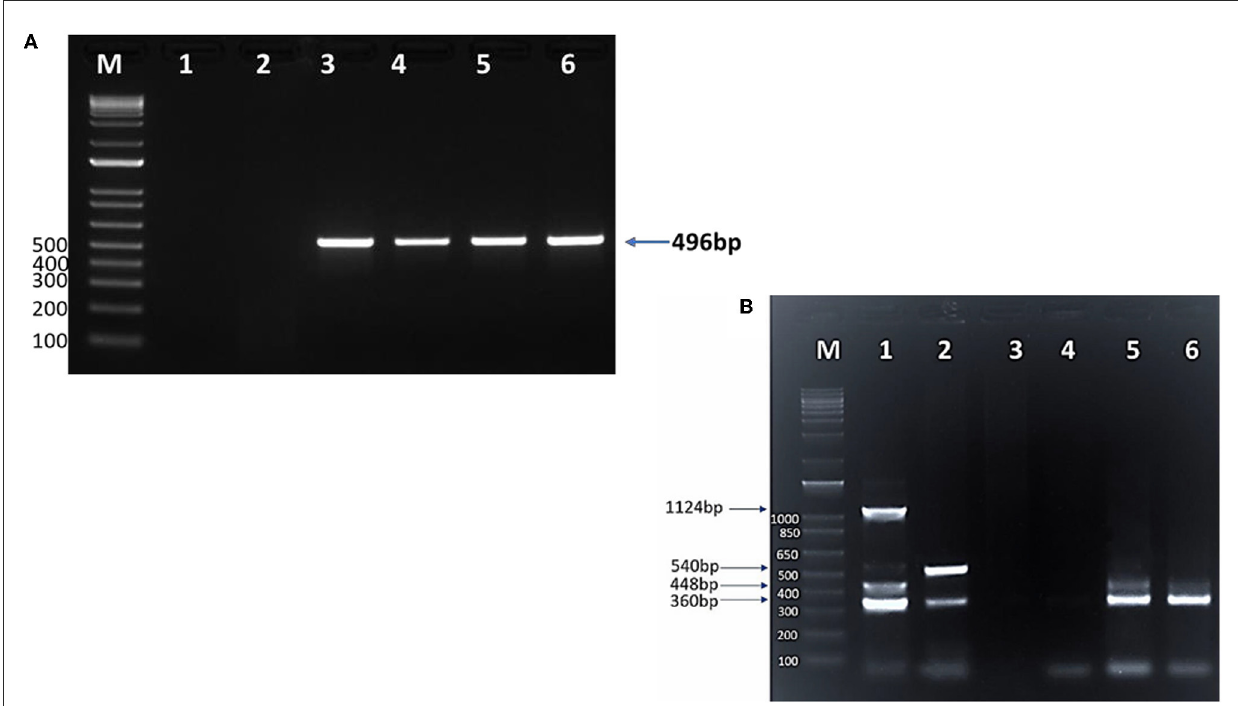
FIGURE3 SYPR safe stained 1.5% agarose gel electrophoresis of (A) cPCR products of Piroplasma spp. M: 1Kb DNA ladder; lane 1: negative control; lane 2: negative camel DNA sample; lane 3: Piroplasma spp. positive control (496 bp); lanes 4, 5, and 6: positive Piroplasma spp. camel DNA samples. (B) Multiplex PCR for detection of T. equi , B. bovis , B. caballi, and B. bigemina in camels. M: 1Kb DNA ladder; lane 1: T. equi (360 bp), B. bovis (448 bp), B. caballi (540 bp), and B. bigemina (1,124 bp) positive controls DNA; lane 2: mixed infection with T. equi and B. caballi ; lane 3: negative control (sterile H 2 O instead of DNA); lane 4: negative DNA sample; lane 5: mixed infection with T. equi and B. bovis ; lane 6: T. equi single